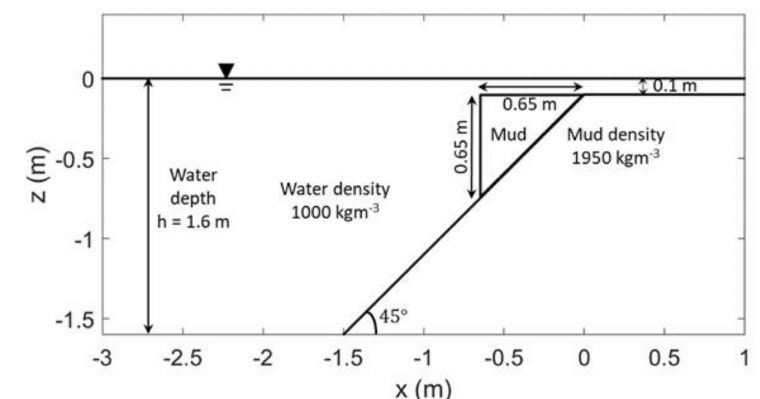
Figure 1. The numerical setup of slump-type tsunami simulations.